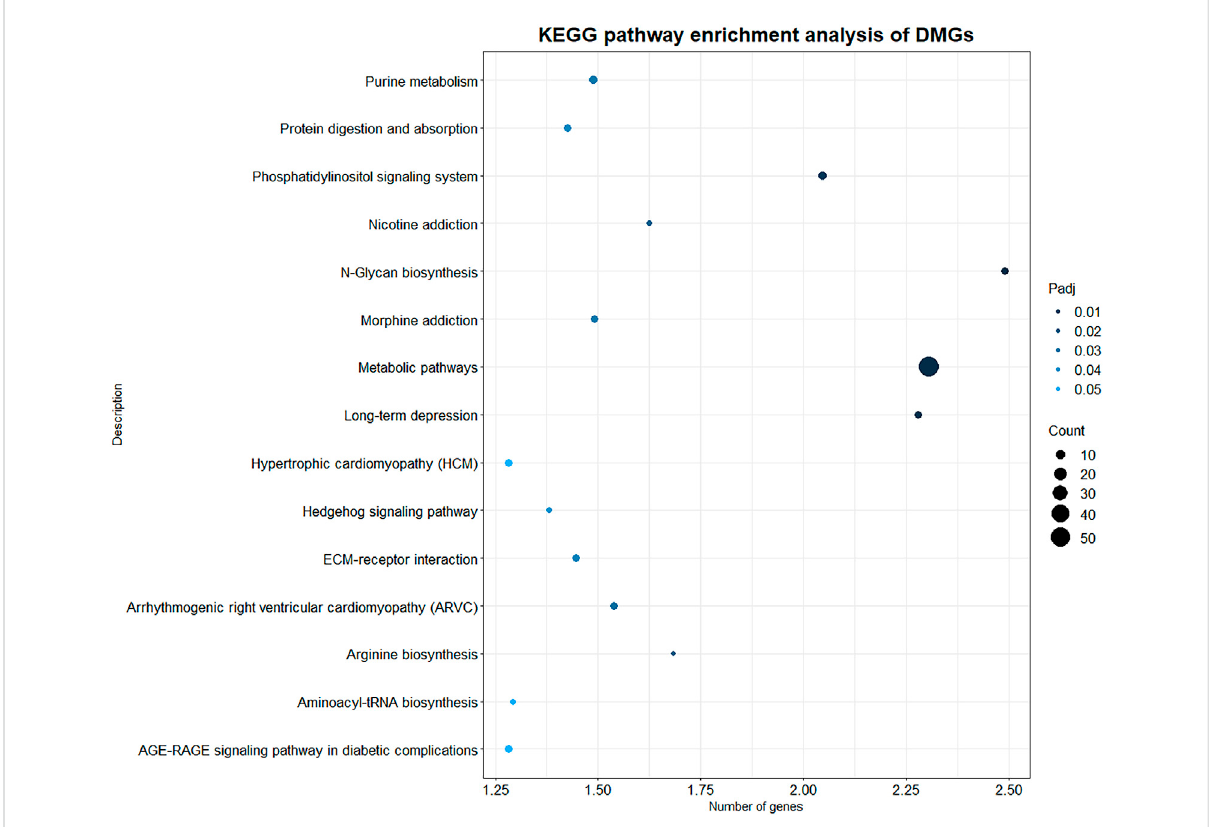
FIGURE 5 KEGG enrichment results of DMGs. X axis indicates the -log10(Padj) of KEGG enriched pathways, Y axis indicates the name of the pathway. The size of the circle represents the number of genes, and the color of the circle represents the p -value signi fi